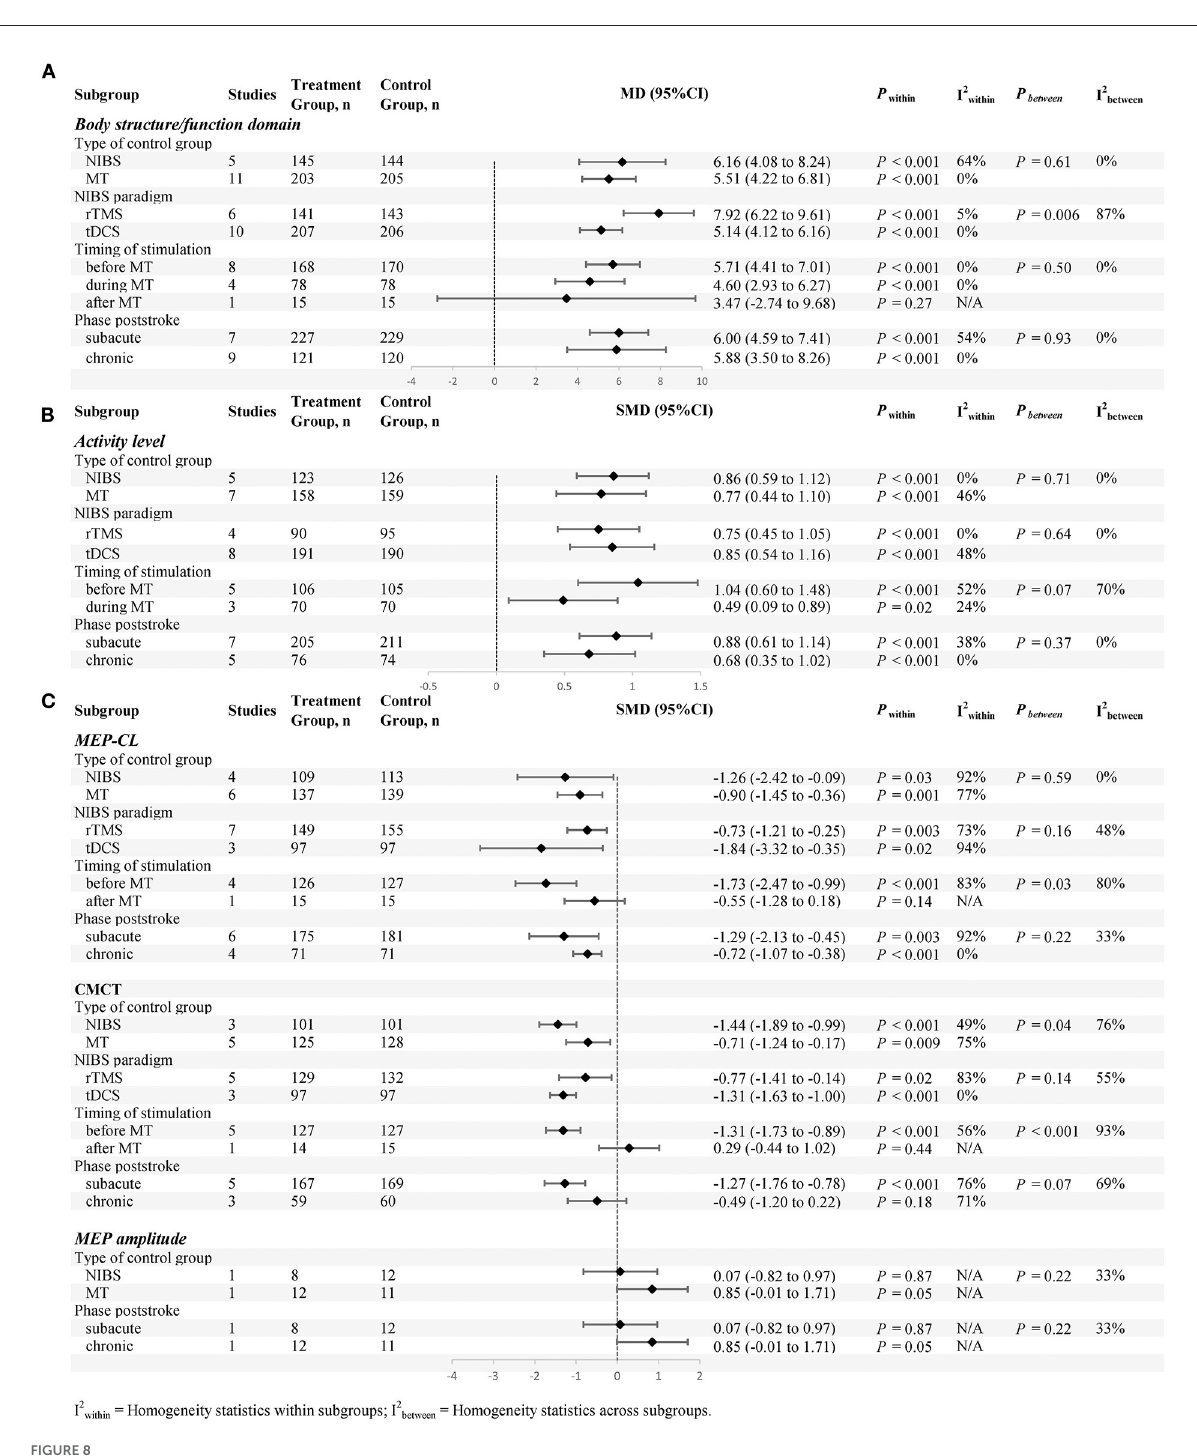
FIGURE8 Subgroup analyses (defined according to the types of control group, NIBS paradigm, stimulation time and phase poststroke) are shown, (A) is body structure/functional domain, (B) is activity levels, (C) is neurophysiological